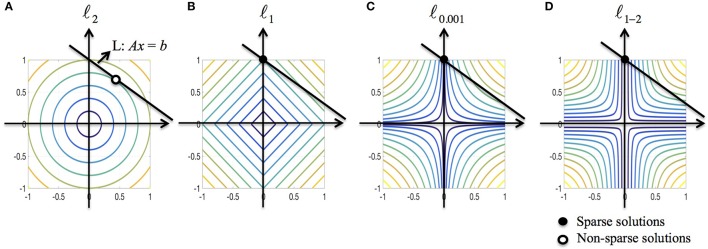
Geometric interpretation of sparsity for various regularizations. (A–D) ℓ2, ℓ1, ℓ0.001 (used to approximate ℓ0), and ℓ1–2 when β = 1. The black line corresponds to the linear constraint, the solid dot specifies the sparse solution and the circular dot specifies the non-sparse solution.